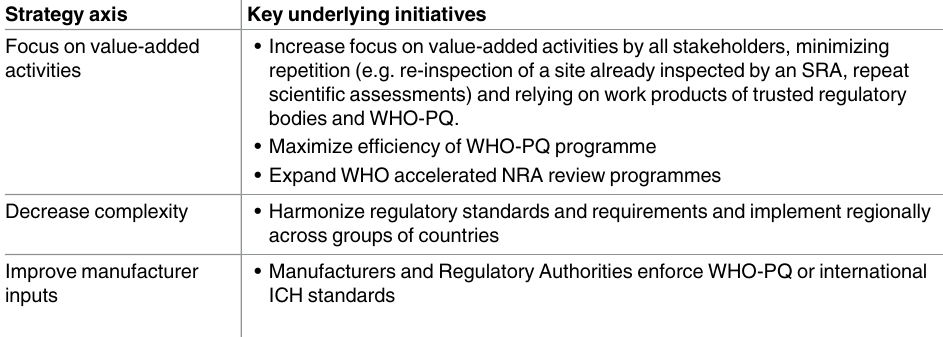
Table 1. A Framework for Optimized Market Authorization System for Products in